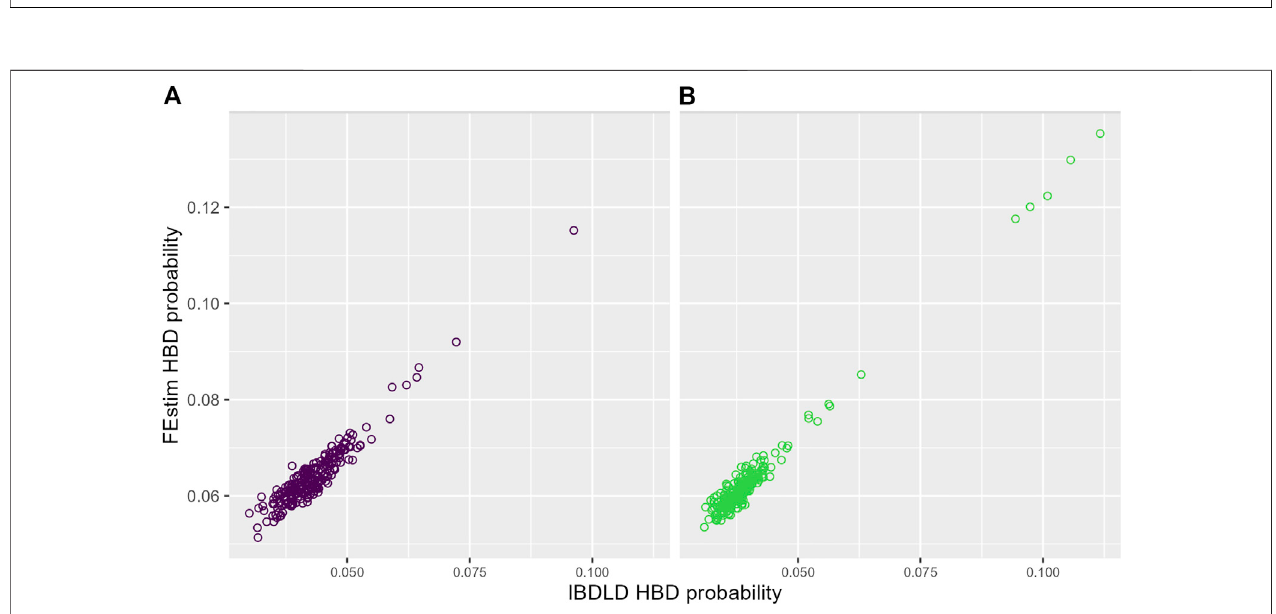
FIGURE 4 | Probability of homozygosity by descent (HBD) from FEstim and IBDLD. Scatter plots of the average (across SNPs and simulation replicates) HBD probabilities estimated by FEstim and IBDLD for (A) the SLSJ study and (B) the Montreal study.